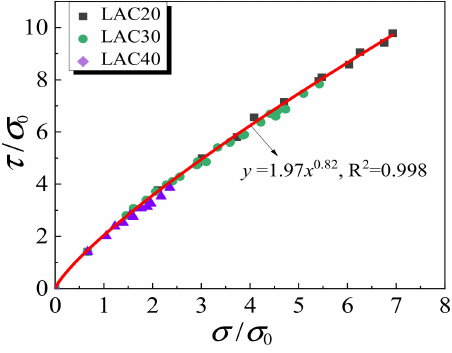
Figure 14. Normalized τ - σ curves.